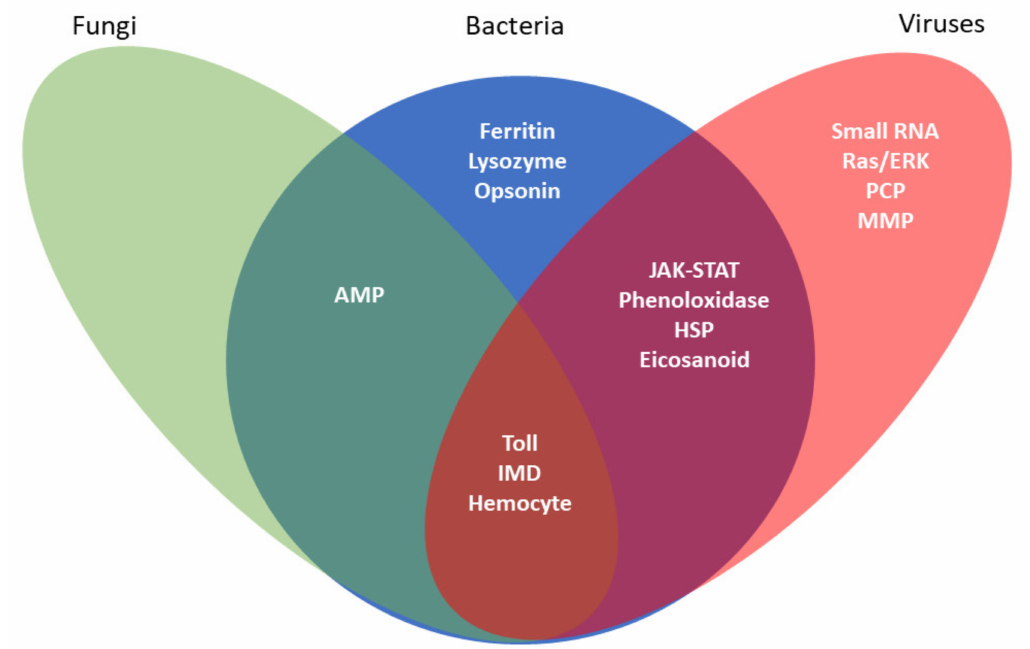
Figure 1. Invertebrate cell lines are amenable for studies of innate immunity. Immortalized cell lines have proven to be an invaluable tool for investigating insects’ varied humoral and cellular immune responses. This Venn diagram illustrates the broad array of immune responses studied in insect and tick cell lines and the pathogens that elicit these defensive responses. Each oval represents the immune response associated with a specific type of pathogen. Overlapping regions represent immune responses elicited by multiple pathogenic